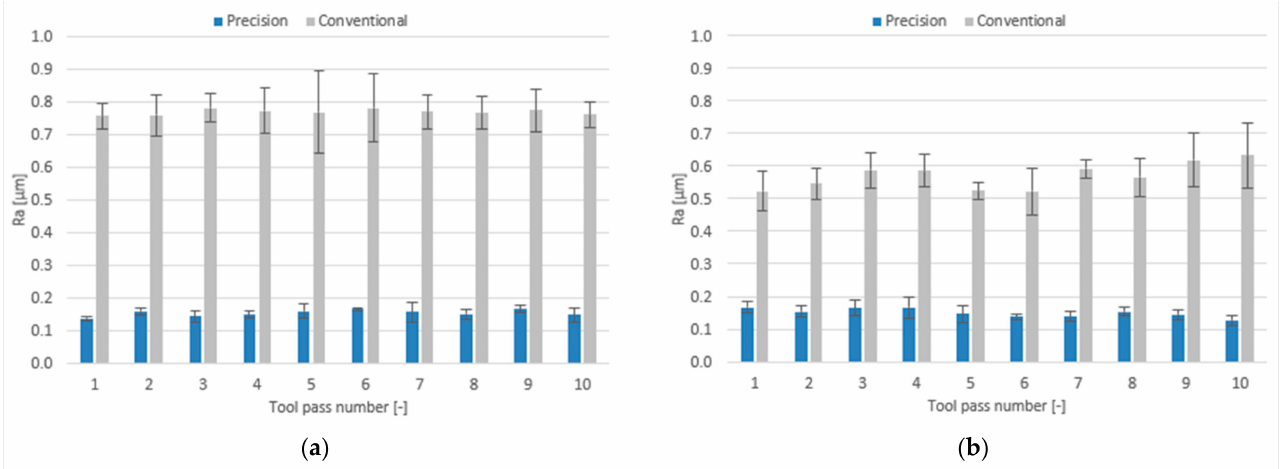
Figure 18. Milling conditions versus surface roughness parameter Ra in the milling process performed using a tool coated with: ( a ) TiB 2 and ( b ) TiAlN.